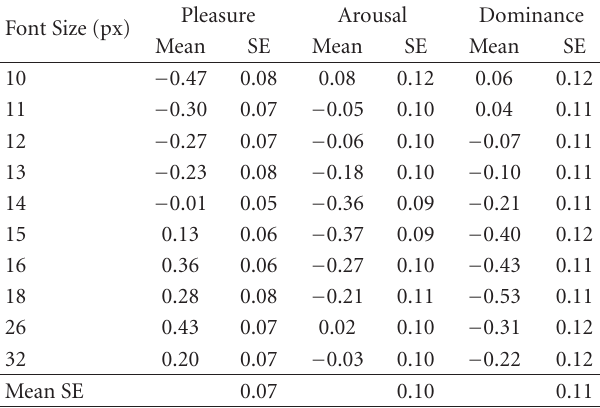
Table 4: The mean values of “Pleasure” (a), “Arousal” (b), and “Dominance” (c) on font size (using black Times New Roman text on white background) with their Standard Errors.